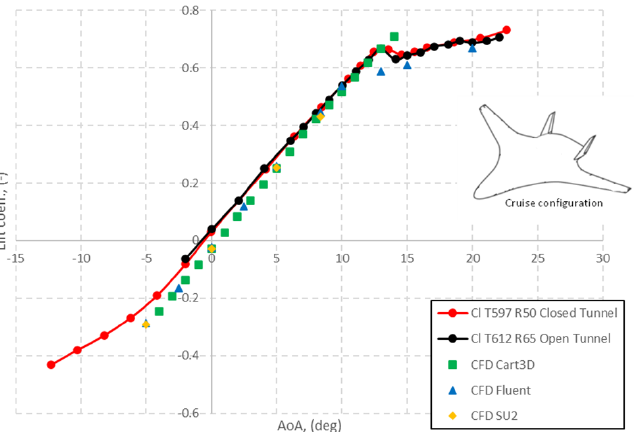
Figure 12. Lift coefficient. Comparison between present results and literature data [6,14–16].